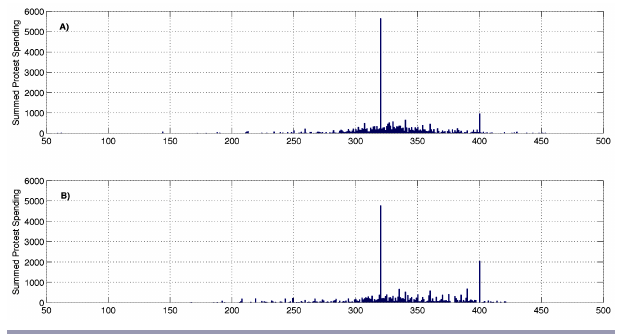
Fig. 10 . Protest spending by targeted water allocation: (A) no- information treatment and (B) information